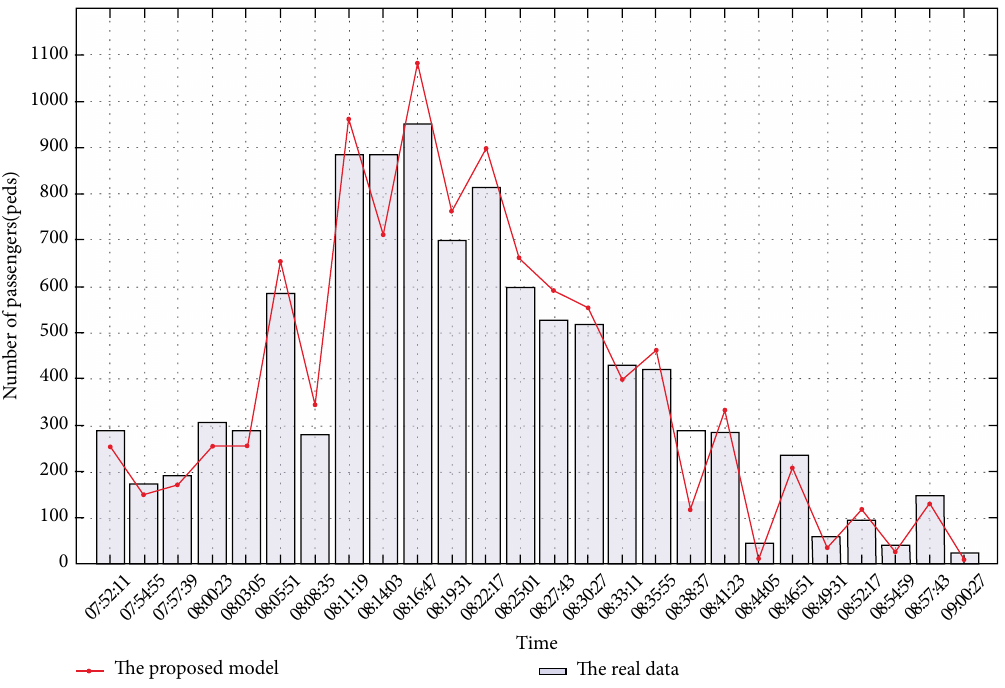
Figure 14: The number of stranded passengers for the process of waiting-boarding trains at UP_L13.